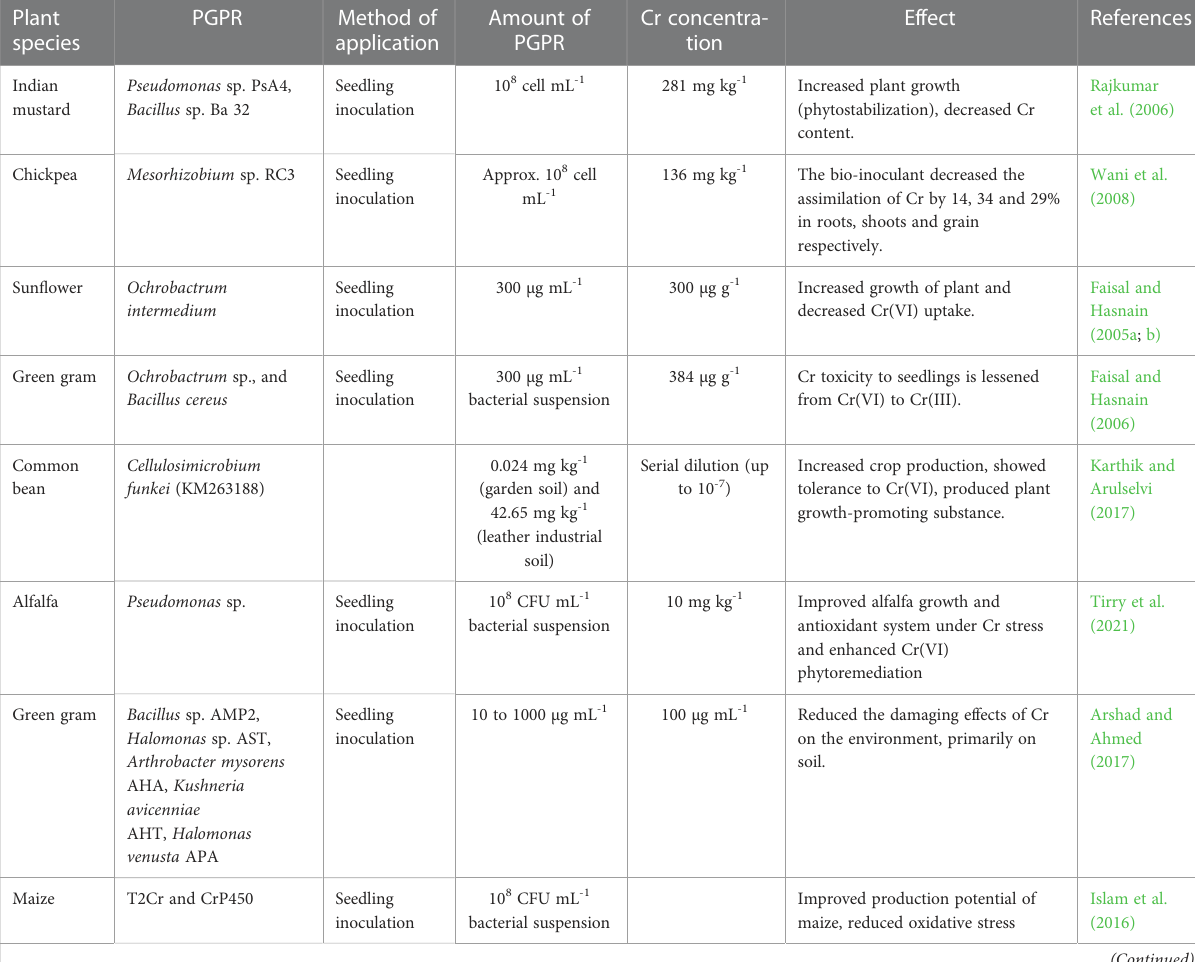
TABLE 4 Effects of plant growth promoting rhizobacteria (PGPR) on plants in Cr-contaminated soils. Plant